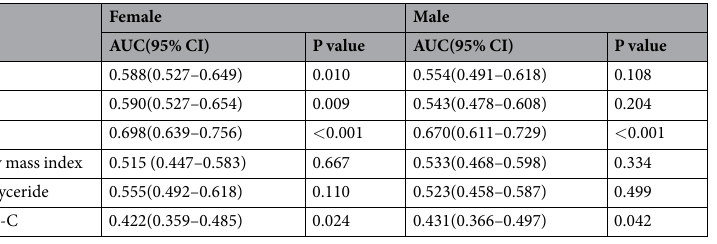
Table 5. ROC analysis of relevant variables in predicting ICAS. ROC, receiver operating characteristic; AUC, area under the ROC curve; 95% CI: 95% confidence intervals; VAI, visceral adiposity index; LAP, lipid accumulation product; FRS, Framingham risk score; HDL-C, high density lipoprotein cholesterol; ICAS, intracranial atherosclerotic